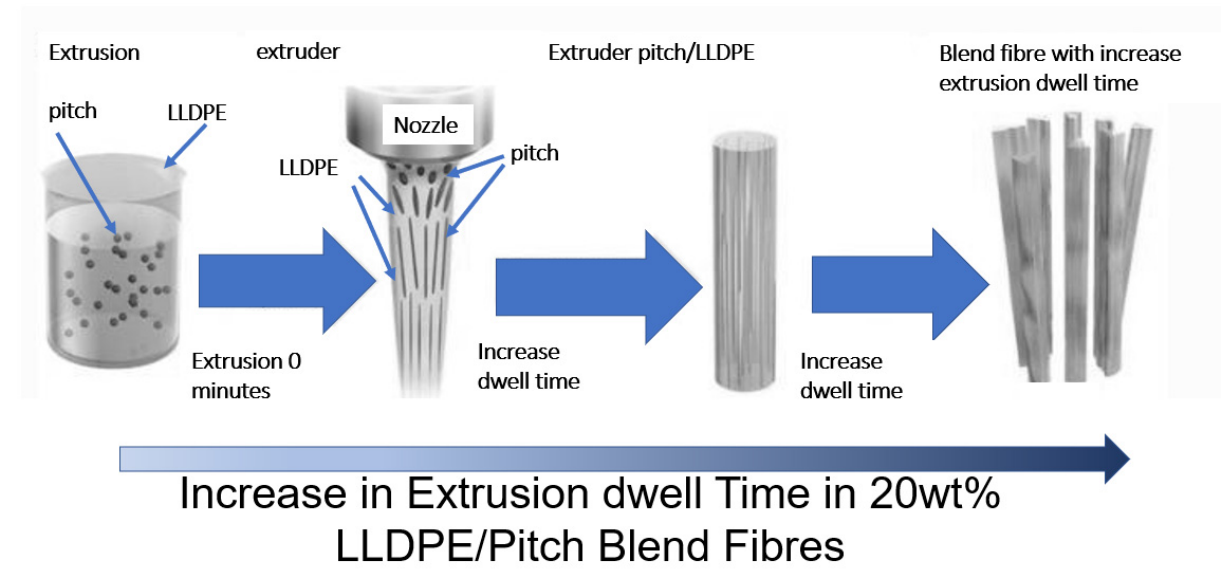
Figure A1. Tensile test setup for melt spun extrusion dwell time MP/PE fibre using a DEBEN Mi ‐ crotest fibre tensile tester and a Leica EC4 microscope.